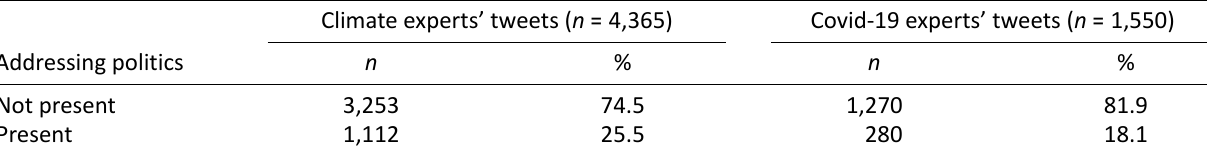
Table 1. Addressing of politics in experts’ tweets ( N = 5,915).